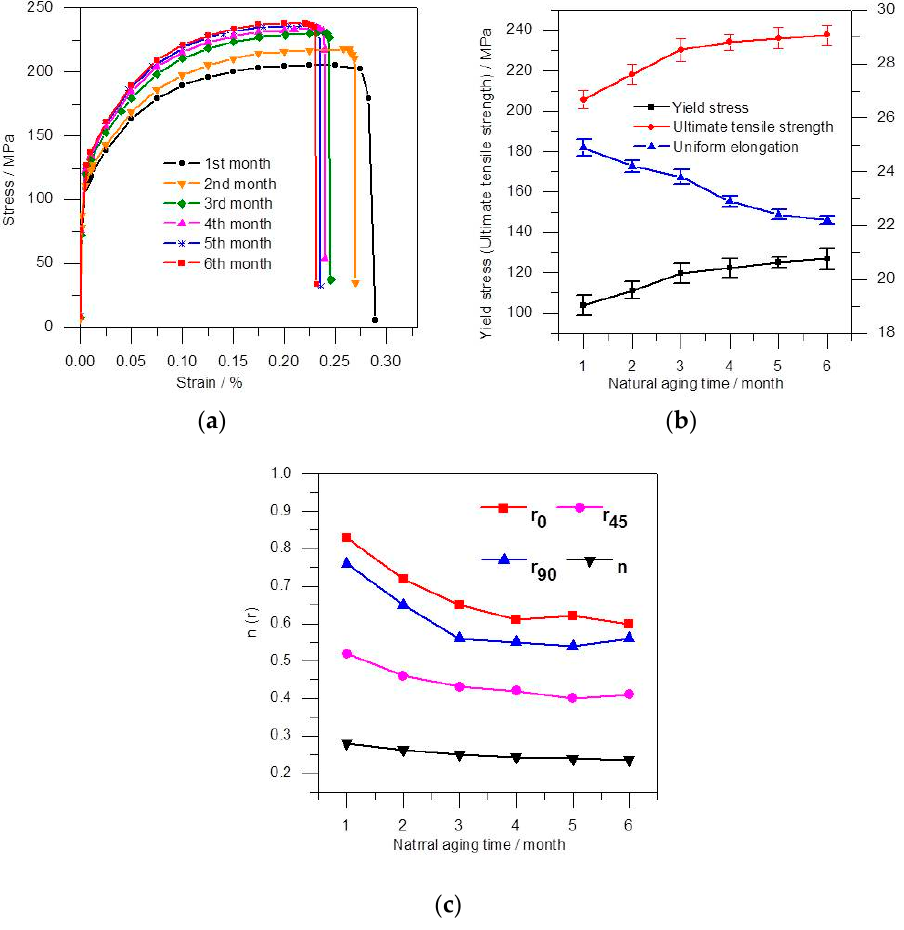
Figure 12. Tensile test results for 6014-T4: ( a ) engineering stress–strain curve; ( b ) tendency graph of strength parameters; and ( c ) variation trend of n -value and r -value.